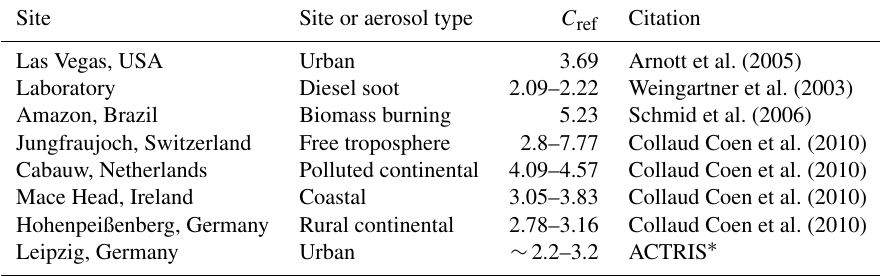
Table 6. Summary table of different multiple scattering enhancement factor ( C ref ) values reported in literature for different types of locations and therefore aerosol